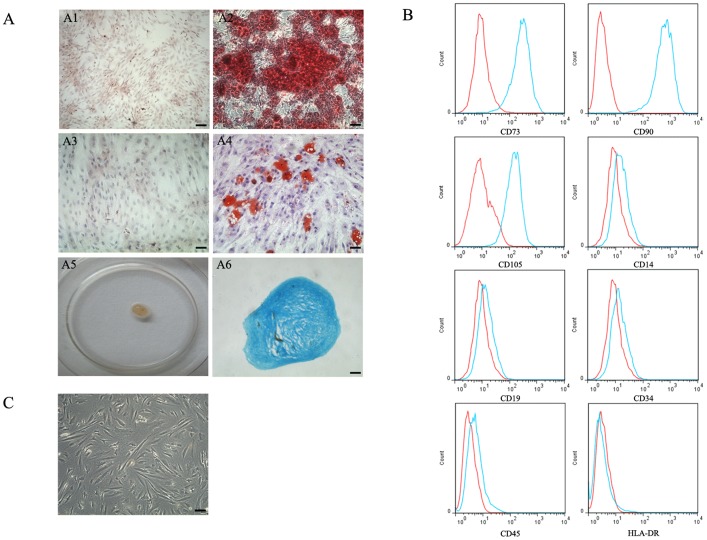
The Identification of CEP-derived stem cells (CESCs).A. In vitro trilineage differentiation assay of CESCs. CESCs were able to osteogenic, adipogenic and chondrogenic differentiation under appropriate conditions. The mineralized matrix, stained with alizarin red was shown in A2 after 21 days osteogenic differentiation, and no alizarin red positive matrix was found in cells cultured in growth medium (A1). The intracellular lipid droplets, stained with Oil Red O was shown in A4 after 21 days adipogenic differentiation, and no adipocytes were found in cells cultured in growth medium (A3). Cells cultured in chondrogenic induction medium formed an aggregate (A5), and its histologic section stained with alcian blue was shown in A6. B. flow cytometric immunophenotyping of CESCs. The green lines represent the fluorescence intensity of cells stained with the indicated antibodies and the red lines represent the negative control cells, which were stained with a non-immunoreactive isotype control antibody. C. Morphology of CESCs. They were spindle-shaped and polygonal-shaped adherent cells. Bar = 100 µm.